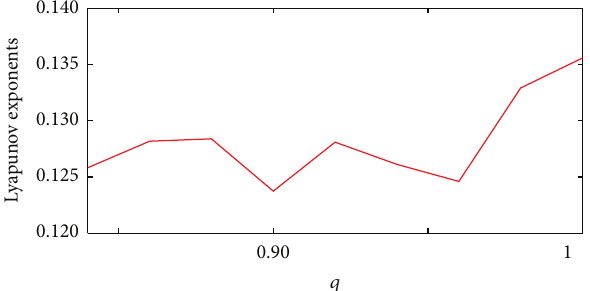
Figure 1: The LLE of fractional-order Chua’s circuit (1) varies as fractional-order 𝑞 .